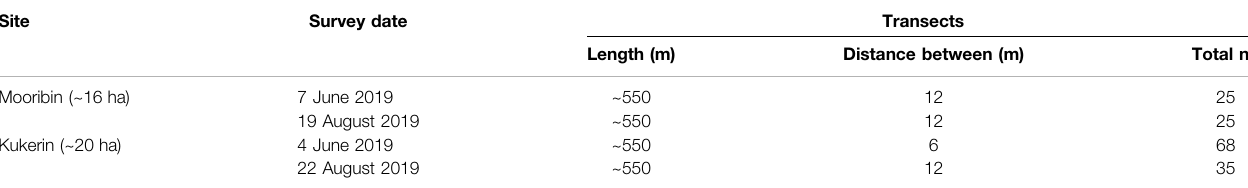
TABLE 1 | Summary of EMI fi eld